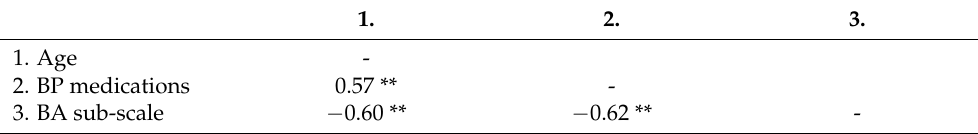
Table 5. Pearson correlations (two-tailed) between age, BP medications, and BA sub-scale.